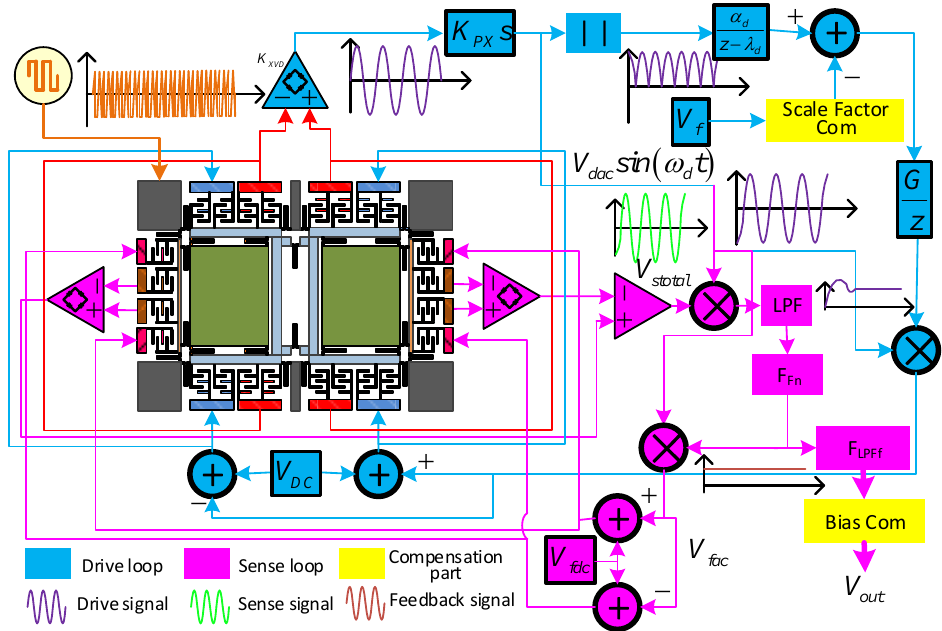
Figure 3. MEMS gyroscope monitoring system schematic.